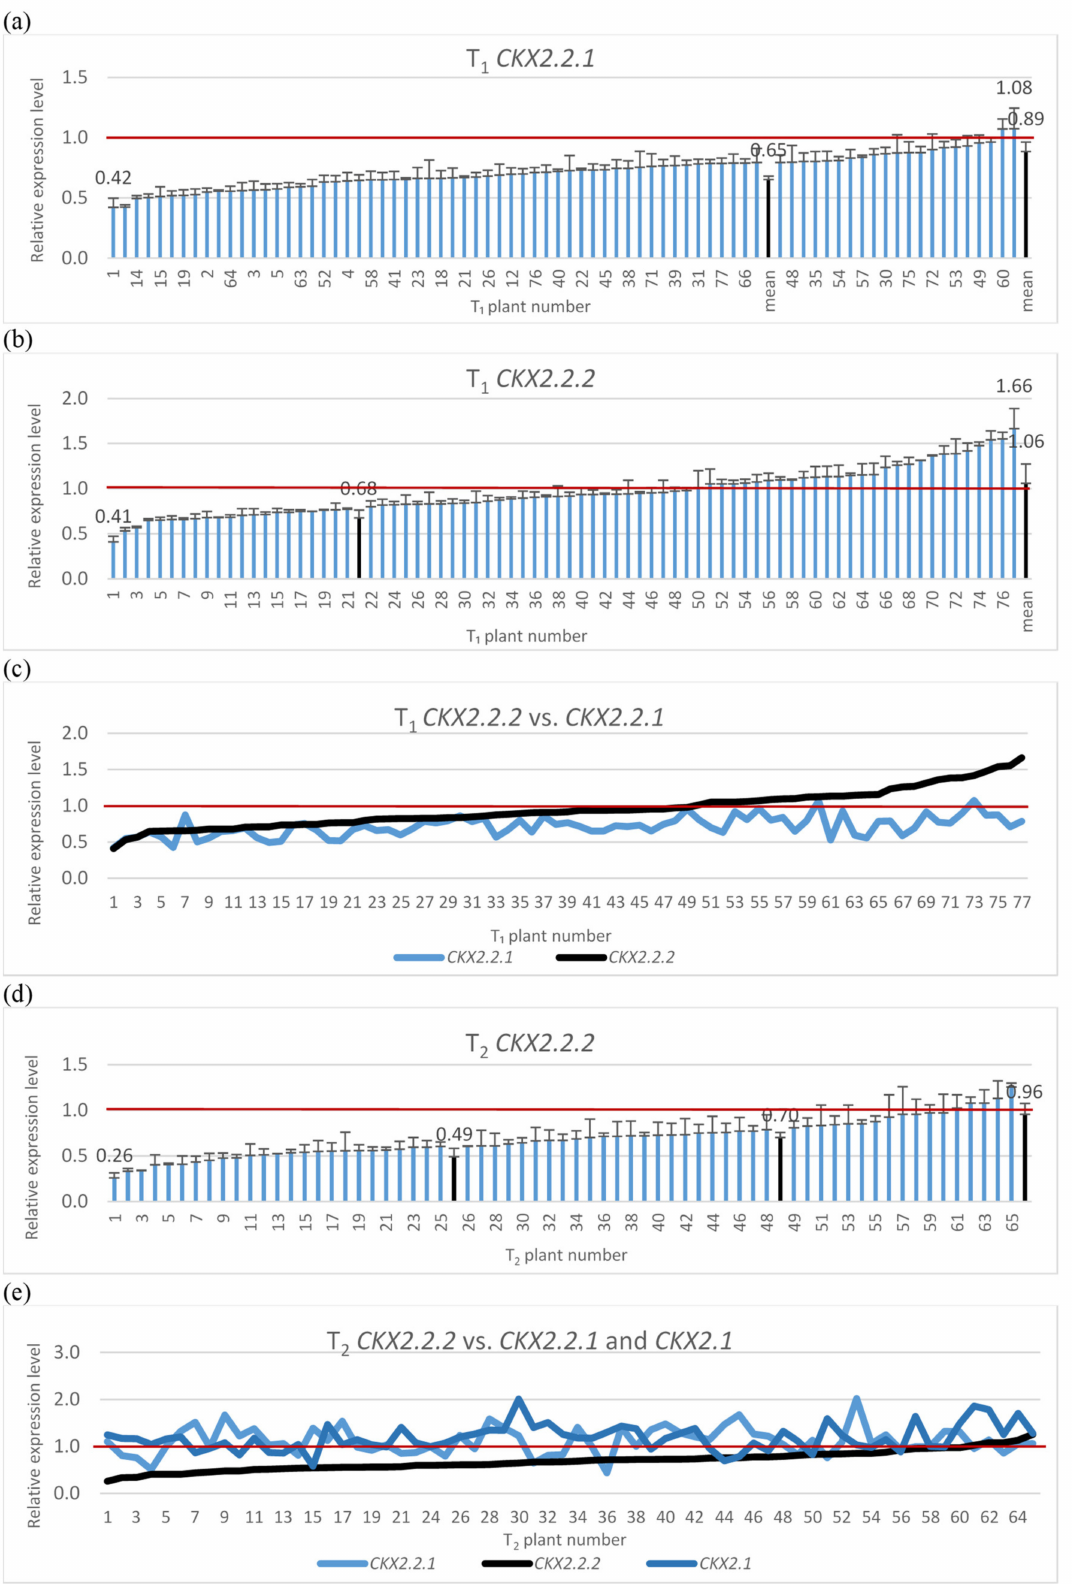
Figure 1. Relative expression levels of silenced TaCKX2.2.1 ( a ), TaCKX2.2.2 ( b ), TaCKX2.2.2 vs. TaCKX2.2.1 ( c ) in T 1 and TaCKX2.2.2 ( d ), and TaCKX2.2.2 vs. TaCKX2.2.1 and TaCKX2.1 ( e ). The error bars denote ± SD. The thresholds of classified plants are 0.6 and